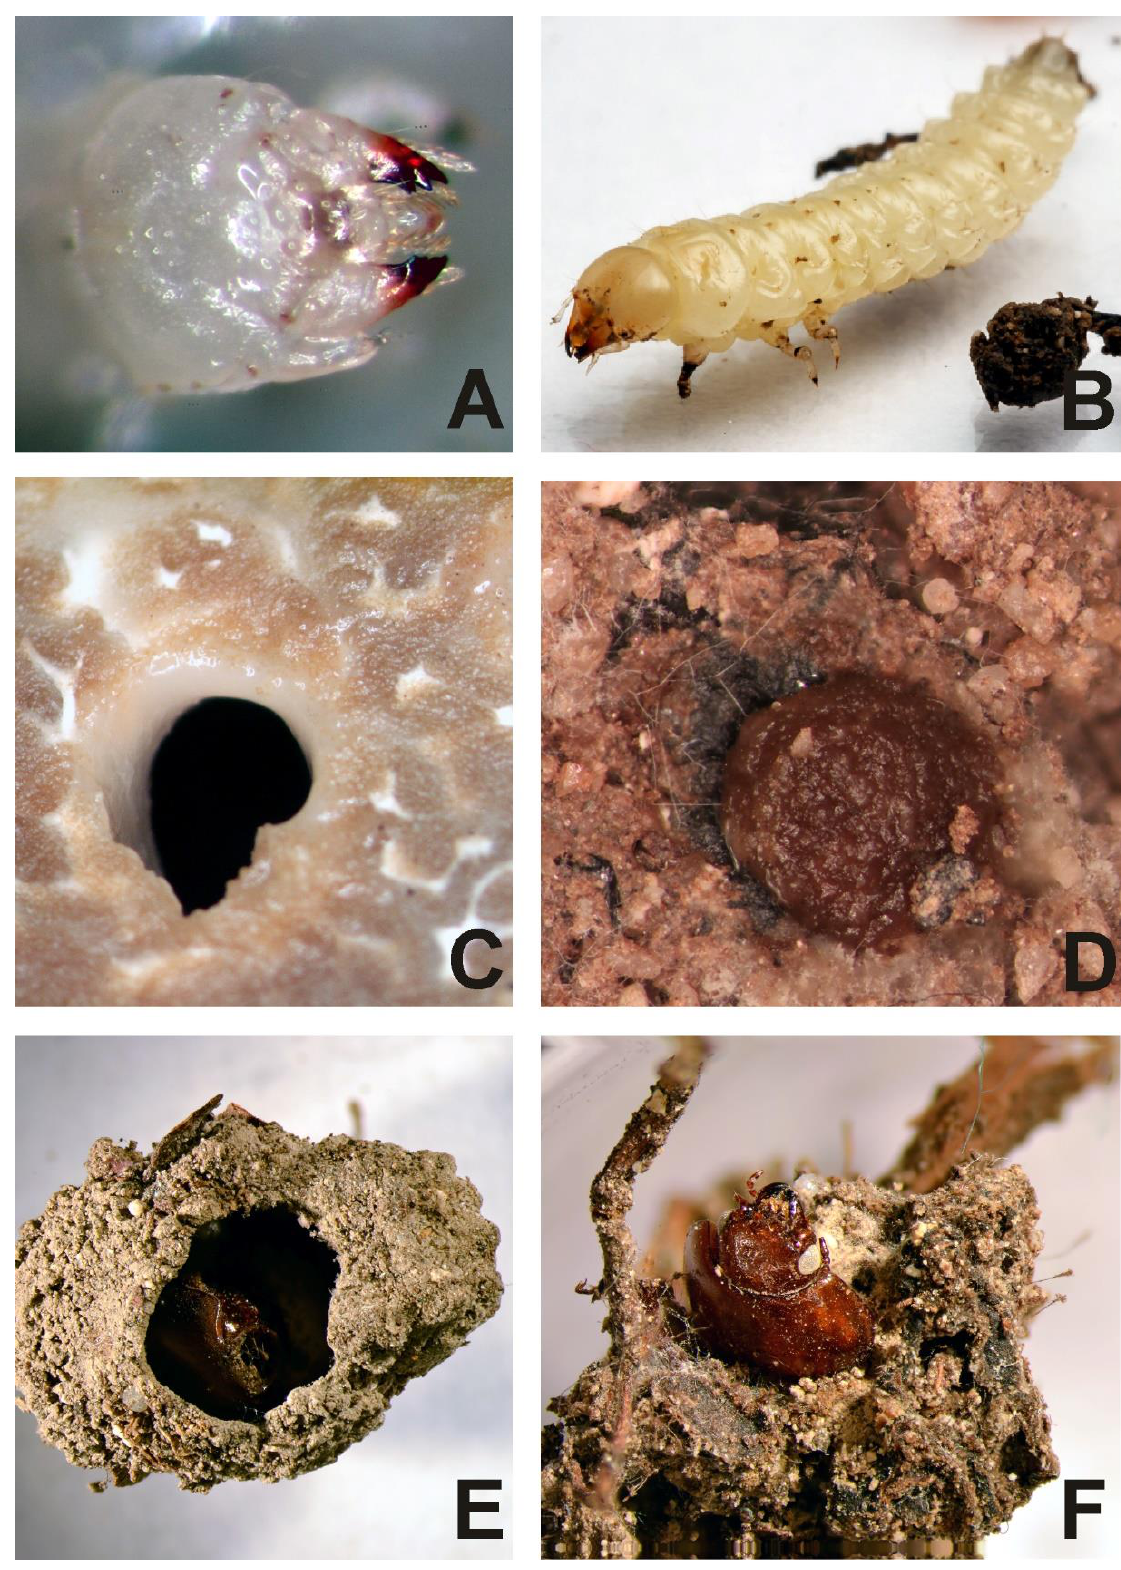
Figure 2. Leiodes cinnamomea . ( A ) Head of the second instar. ( B ) Habitus of larva of the third instar. ( C ) Entrance of corridor made by beetles in Tuber aestivum . ( D ) The cup of cocoon made by larva from chewing hymenium of truffle. ( E , F ) Adult beetle in cocoon formed from soil.